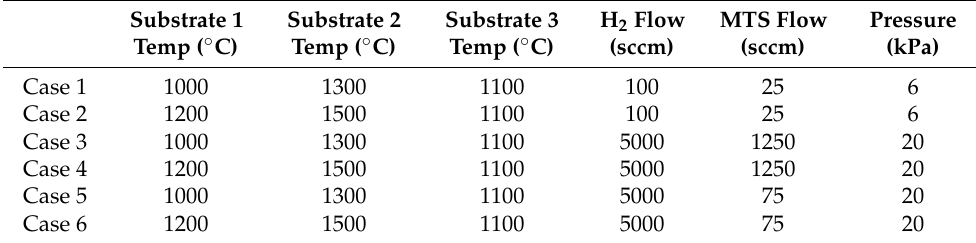
Table 1. Calculation conditions in this